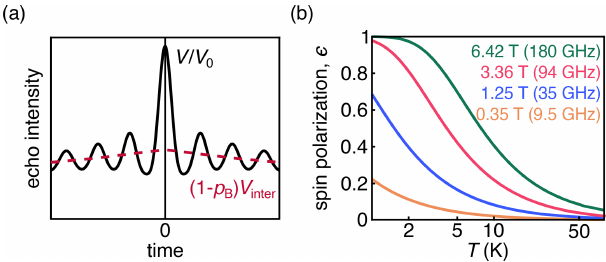
Figure 1. (a) DEER signal (black) with the oscillatory intramolec- ular signal; the contribution from the exponentially decaying inter- molecular signal is shown in pink. (b) Dependence of thermal spin polarization (cid:15) on magnetic field and